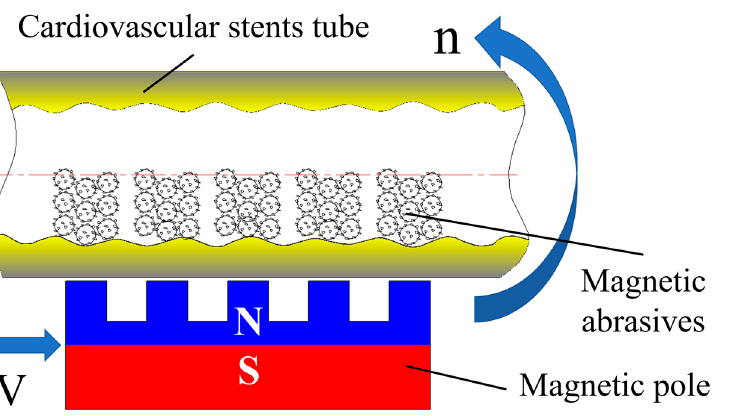
Figure 5. Principle diagram of magnetic particle finishing on the inner wall of ultra-slender cardio- vascular stents tube.